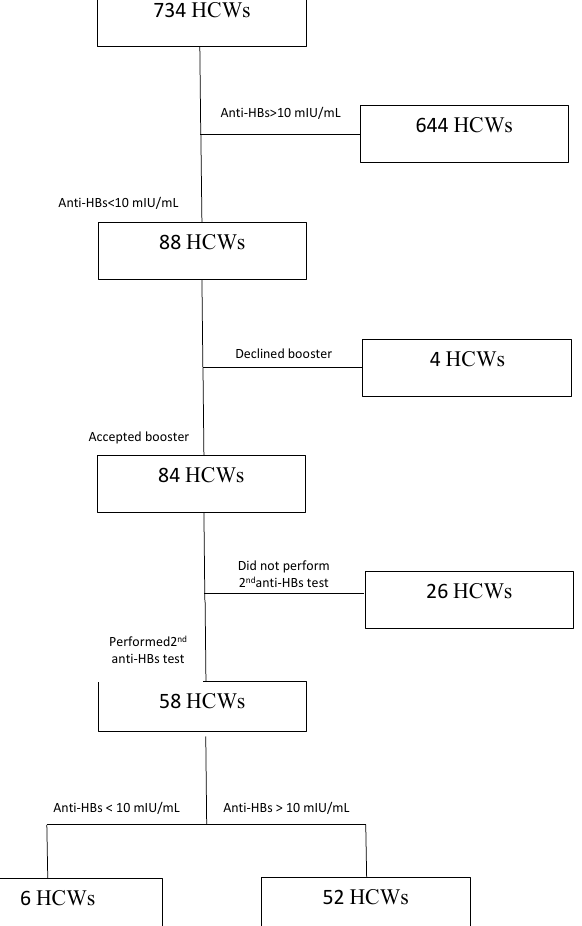
Figure 1. Study participants’ flow chart.